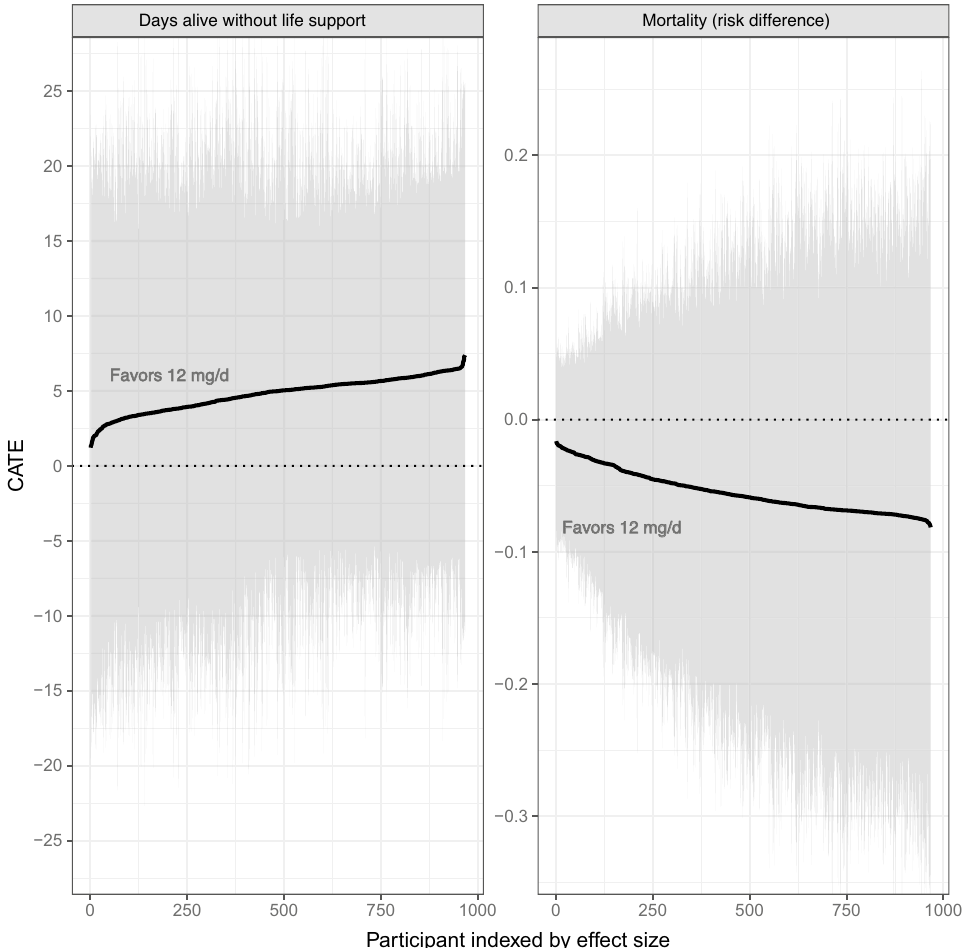
Figure 1. Estimated conditional average treatment effects (CATEs) for each individual in the trial. The left panel provides estimates (solid line) and 95% credible intervals (shaded area) for the difference in days without life support at 90 days, while the right panel provides estimates (solid line) and 95% credible intervals (shaded area) for the mortality risk